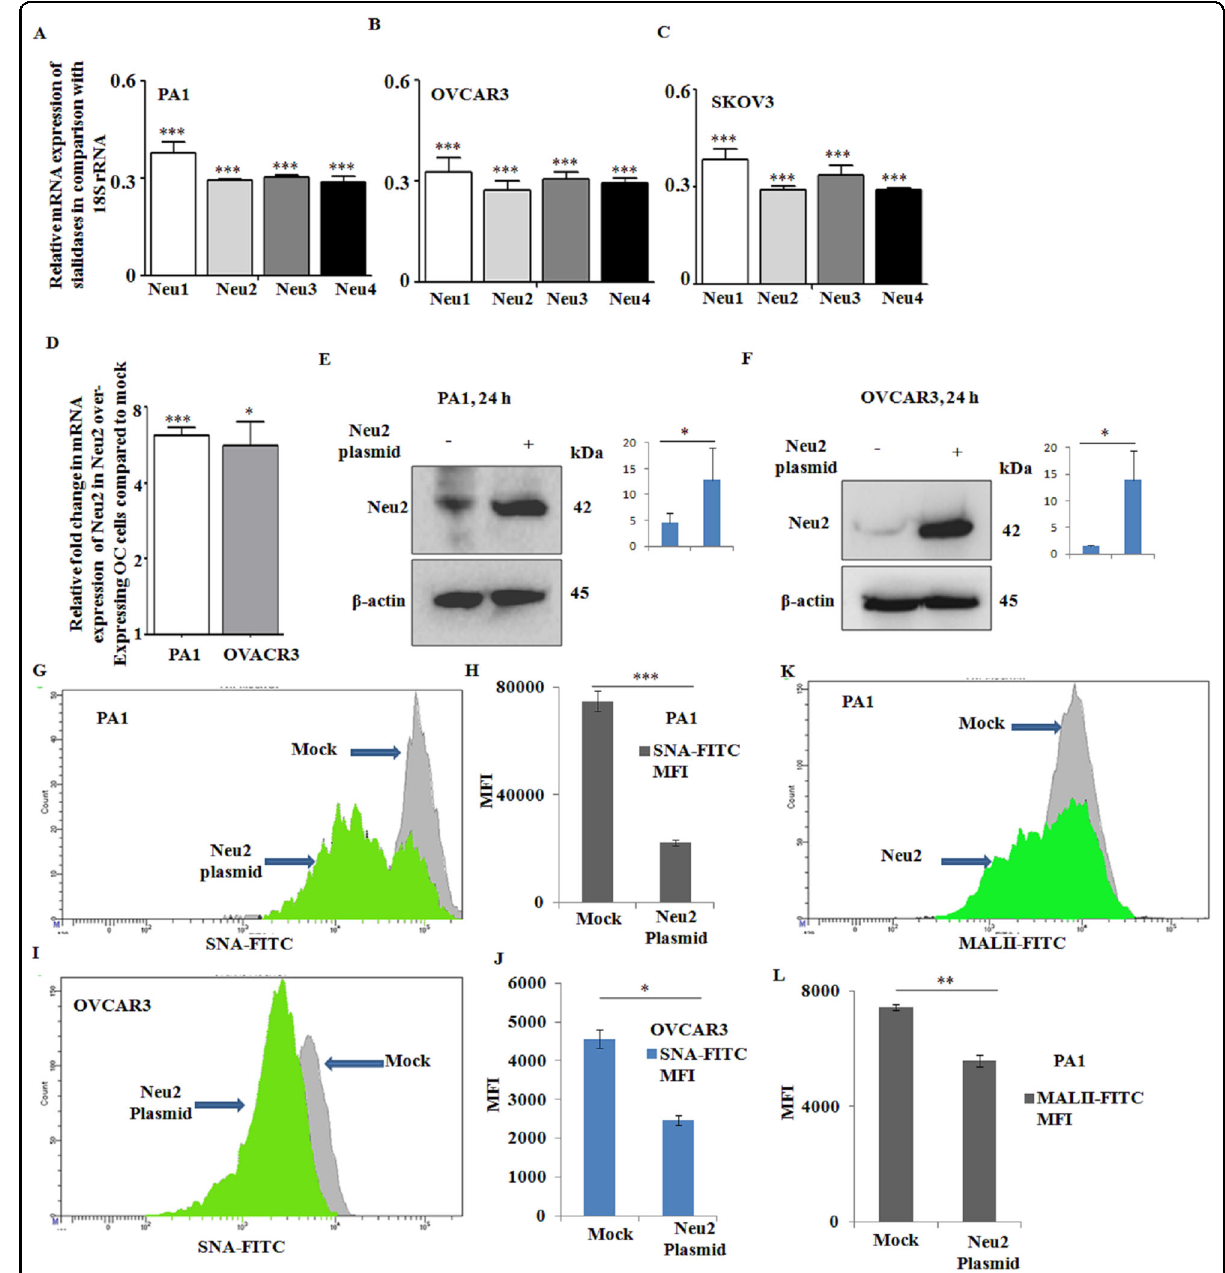
Fig. 1 Overexpressed Neu2 demonstrated preferential speci fi city toward α 2,6-linked sialic acids on OC cells. A – C Genetic expression levels of Neu1, Neu2, Neu3, and Neu4 in PA1 ( A ), OVCAR3 ( B ), and SKOV3 ( C ) ovarian cancer cell lines by real-time PCR analysis. Relative mRNA expression was expressed in comparison to 18S rRNA. D Relative fold change in the Neu2 mRNA level in PA1 and OVCAR3 after overexpression with Neu2 plasmid (24 h) compared to mock cells was analyzed by real-time PCR analysis. E , F Western blot analysis was performed to con fi rm the enhanced Neu2 protein levels in transfected PA1 ( E ) and OVCAR3 ( F ) cells compared to mock using an anti-Neu2 antibody. β -Actin was used as a loading control. G – J FACS analysis showing that Neu2 overexpression decreased the FITC-SNA binding in PA1 ( G ) and OVCAR3 ( I ) compared to mock cells. Bar graphs represent the MFI values of FITC-SNA-stained mock and Neu2-overexpressed PA1 ( H ) and OVCAR3 ( J ) cells. K , L Binding of FITC-MALII with mock and Neu2-overexpressed PA1 ( K ) by fl ow cytometry. The MFI values are compared by plotting a bar graph ( L ). The results are represented as mean ± SD from independent experiments and p values (* p < 0.05; ** p < 0.01; *** p < 0.001; two-tailed t test) represented the signi fi cant differences between the means of the two test